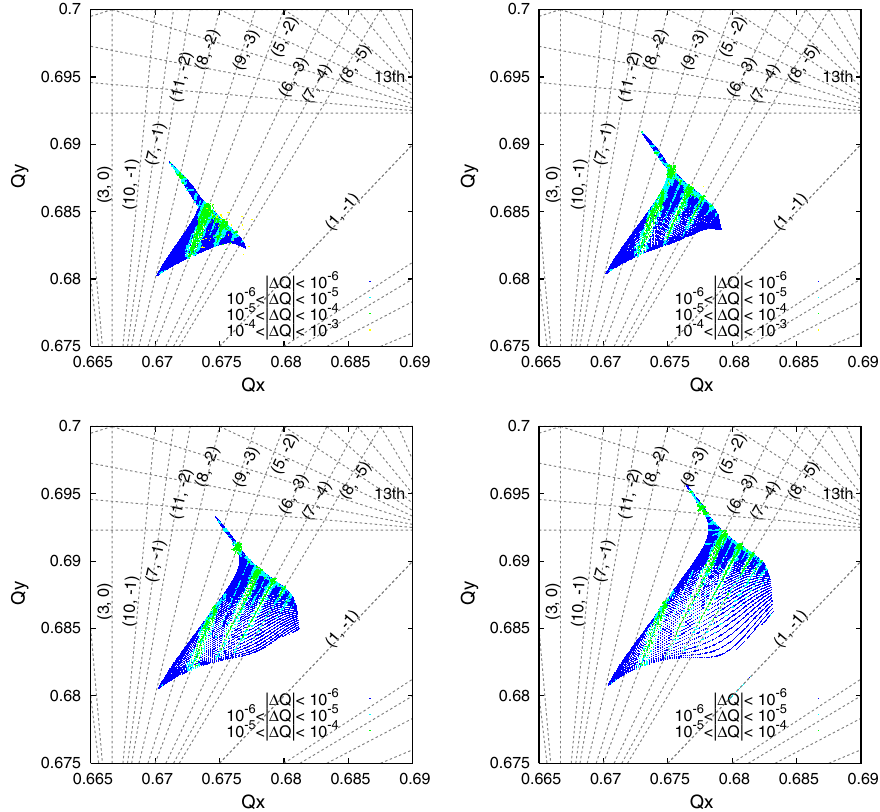
FIG. 5. Tune footprints and tune diffusion with half head-on beam-beam compensation. The bunch intensities are 1 : 5 (cid:2) 10 11 (top left), 2 : 0 (cid:2) 10 11 (top right), 2 : 5 (cid:2) 10 11 (bottom left), and 3 : 0 (cid:2) 10 11 (bottom